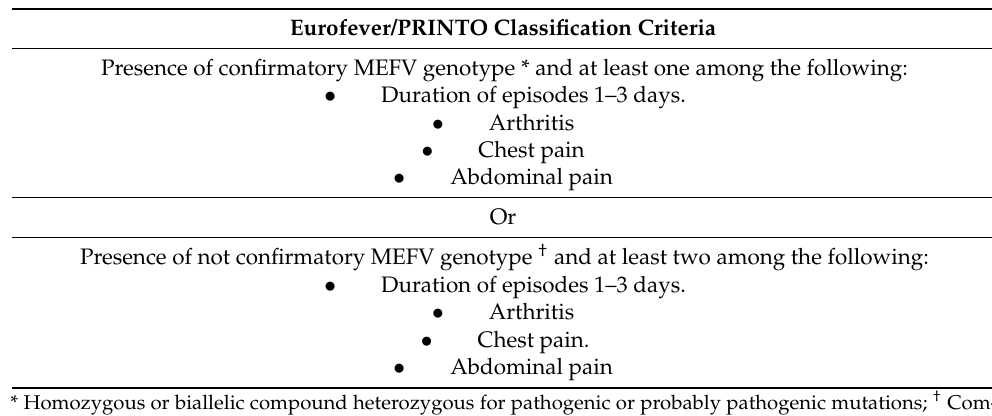
Table 1. Eurofever/PRINTO classification criteria for